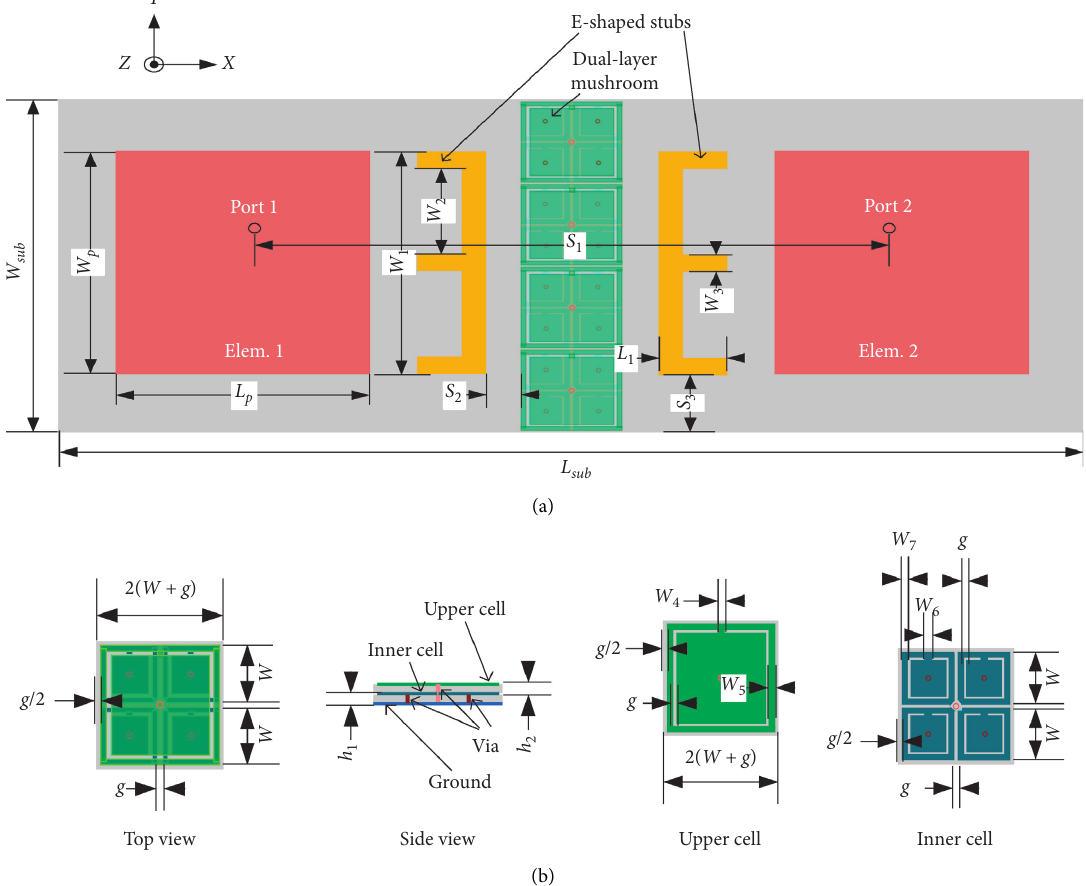
Figure 1: Geometry of the proposed antenna: (a) top view; (b) dual-layer mushroom cell. Table 1: Dimensions of optimized parameters of the proposed antenna.